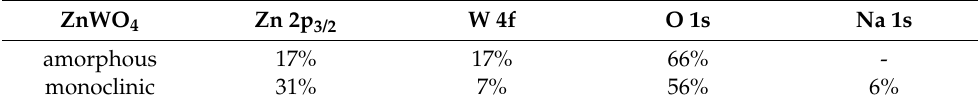
Figure 4. Survey, Zn 2p 3/2 , O 1s and W 4f core level, and valence band (VB) XP spectra of a 100 nm thick monoclinic ZnWO 4 film. Using tabulated sensitivity factors 2.77, 15.13 and 10.35 for O 1s, Zn 2p 3/2 and W 4f the composition is 0.60, 0.21, 0.19. Table 1. Surface stoichiometry amorphous and monoclinic ZnWO